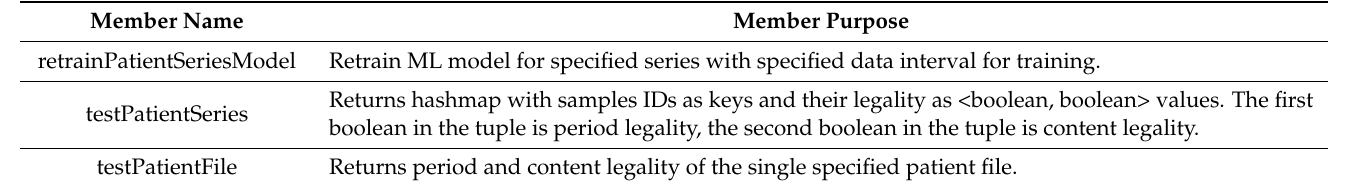
Table A2. Members of LegalityCheckingProvider